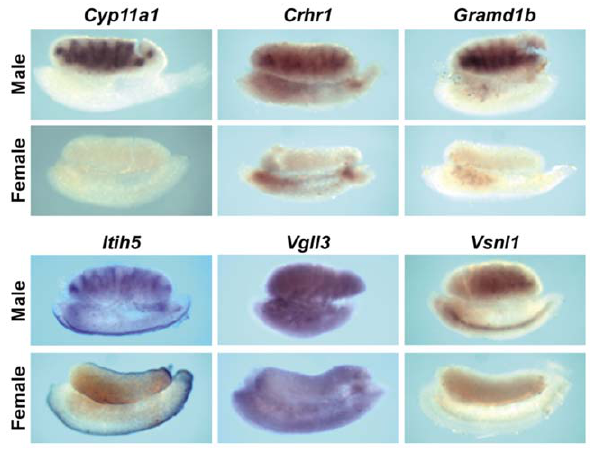
Figure 2. Fetal mouse gonad whole-mount ISH of select candidate Leydig cell-specific genes. Shown are ISH patterns of GD13 mouse gonads with attached mesonephros below the gonad. The distribution of fetal testis Leydig cells is shown in the male Cyp11a1 image. doi:10.1371/journal.pone.0047359.g002 PLOS ONE |